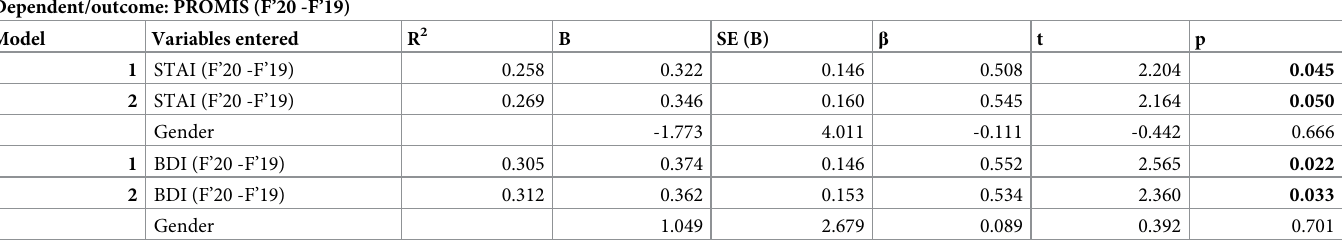
(Fig 4; Table 2, STAI: R 2 = 0.269, p = 0.050; BDI: R 2 = 0.312, p = 0.033). In addition, individu- als who reported that they got less sleep mid-pandemic relative to pre-pandemic also reported higher mid-pandemic depression and anxiety scores, but interestingly, not sleep disturbance scores (Fig 5; STAI: t (14) = -2.186, p = 0.046; BDI: t (13) = -3.168, p = 0.007; PROMIS: t (12) = -0.800, p = 0.439). No significant differences in mental health measures were observed for indi- viduals reporting that they slept more mid-pandemic relative to pre-pandemic (STAI: t (3) = -2.587, p = 0.081; BDI: t (3) = -1.476, p = 0.236; PROMIS; t (1) = 0.059, p = 0.963). Impact of pandemic on objective sleep measures Overall, objective measures for sleep duration and the percentages of REM, deep and light sleep on free days via Fitbit analysis did not differ between mid-pandemic and pre-pandemic measures (Table 3, Sleep duration: Z = - 0.260, p = 0.795; % REM: Z = - 0.081, p = 0.935; % deep: Z = - 0.730, p = 0.465; % light: t (21) = 0.147, p = 0.885). However, an increase in sleep disturbance scores between mid- and pre-pandemic tended to be only weakly associated with Table 2. Regression analysis of differences between mid- and pre-pandemic sleep disturbance (PROMIS) (as outcome) and anxiety (STAI) and depression (BDI). Dependent/outcome: PROMIS (F’20 -F’19)